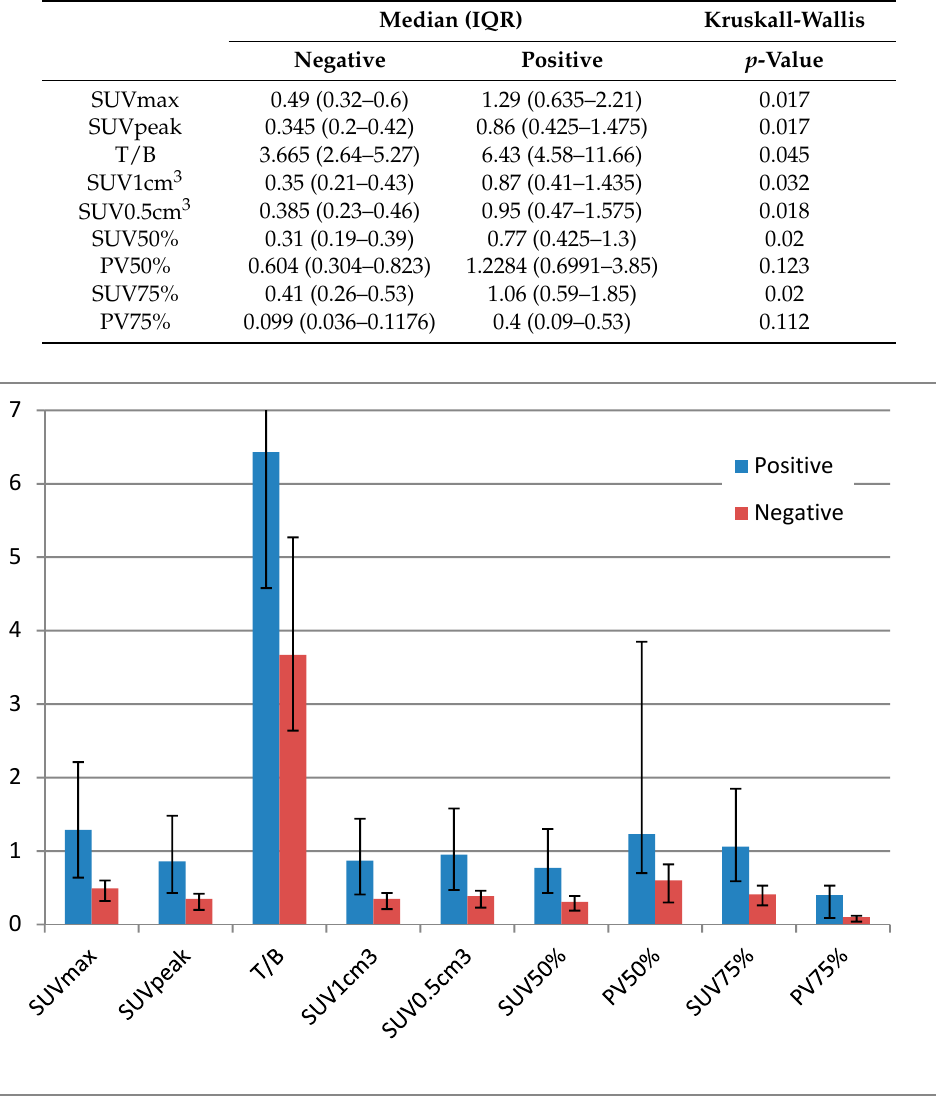
Figure 1. Median and IQR depicted as graph.